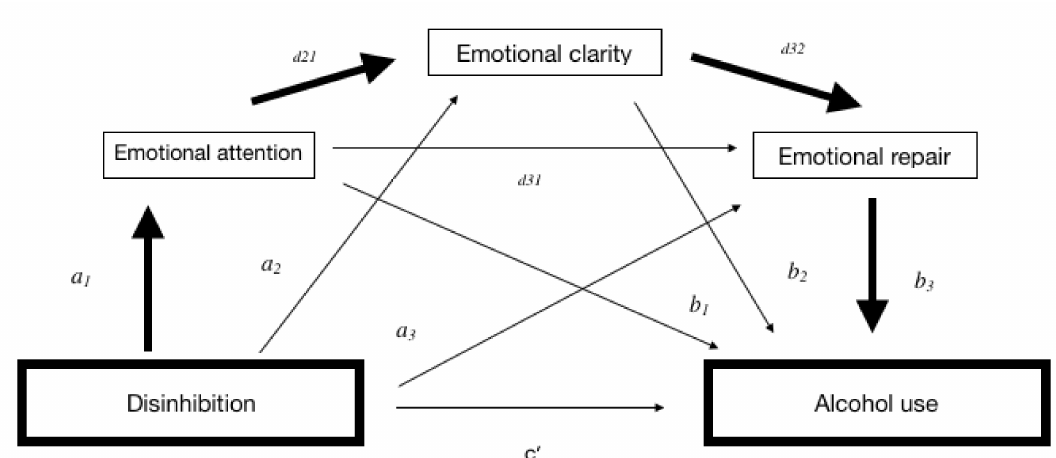
Figure 1. Representation of the indirect e ff ects for serial mediation. Notes: direct e ff ect ( c ’); total indirect e ff ect ( a ) represents the association between the predictors DIS and three mediators ( a 1 , a 2 , and a 3 ); total indirect e ff ect ( b ) refers to the role of the three mediators in the use of alcohol ( b 1 , b 2 , and b 3 ); total indirect e ff ect ( d ) refers to the relationship of the three mediators with each other ( d 21 , d 32 , and d 31